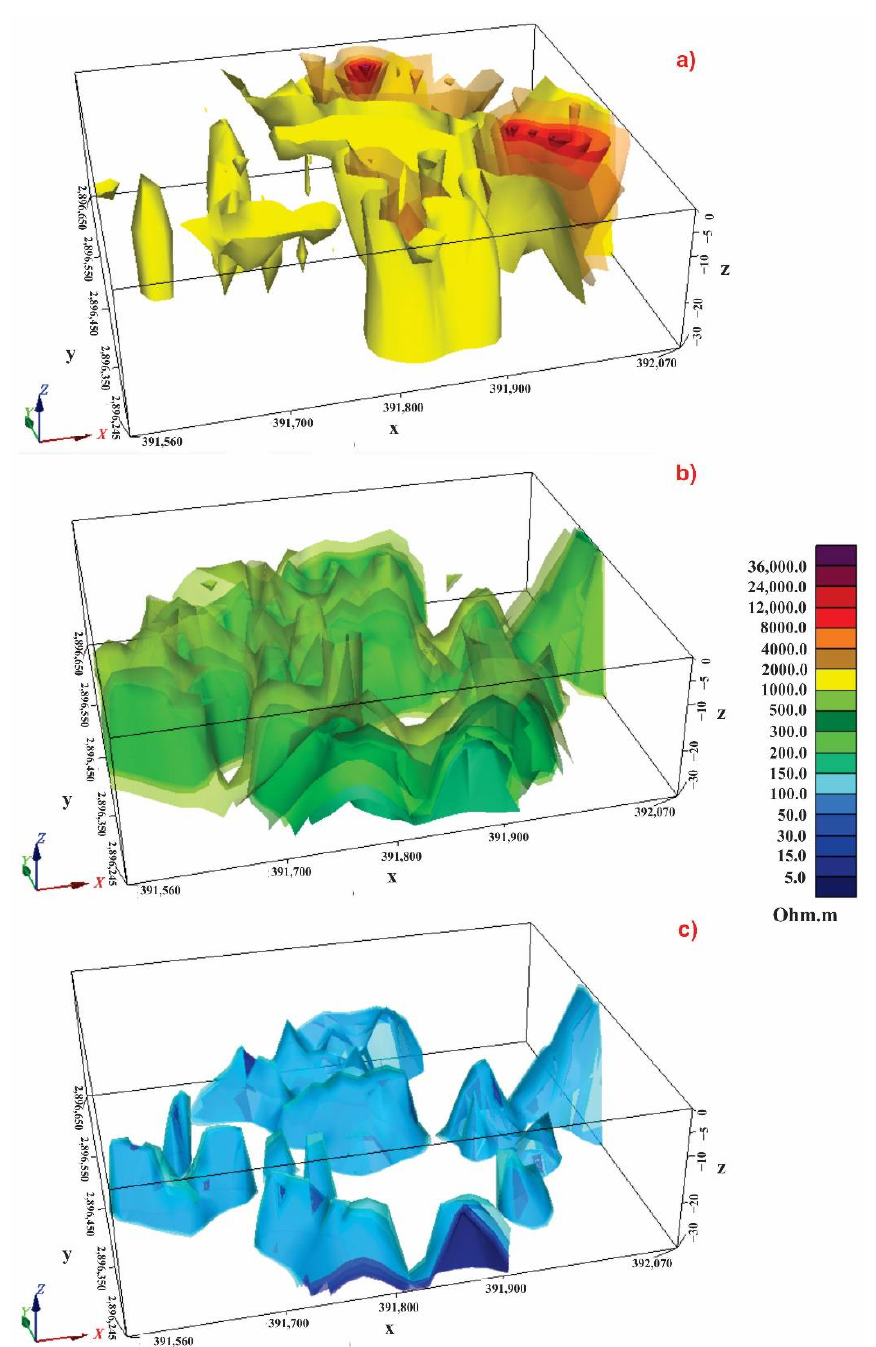
Figure 10. A 3D illustration of the major detected subsurface geoelectric zones in the study site, where ( a ) is the first geoelectric zone representing the wadi deposits, ( b ) is the second geoelectric zone corresponding to medium sand, and ( c ) is the third geoelectric zone representing the muddy sand (saturated with groundwater).